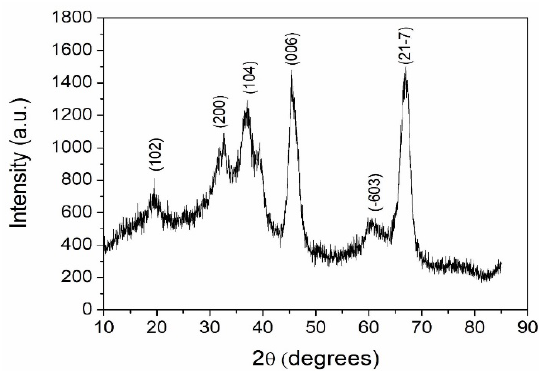
Figure 3. XRD pattern of Al 2 O 3 nanoparticles.